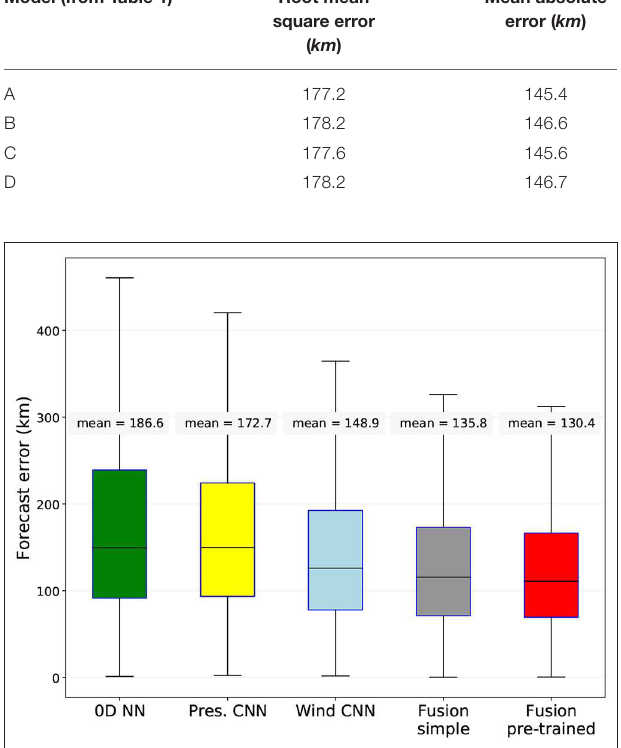
TABLE 3 | Performance of candidate configurations (Wind CNN) on 24 h storm track prediction, on the validation set using wind fields. Model (from Table 1)